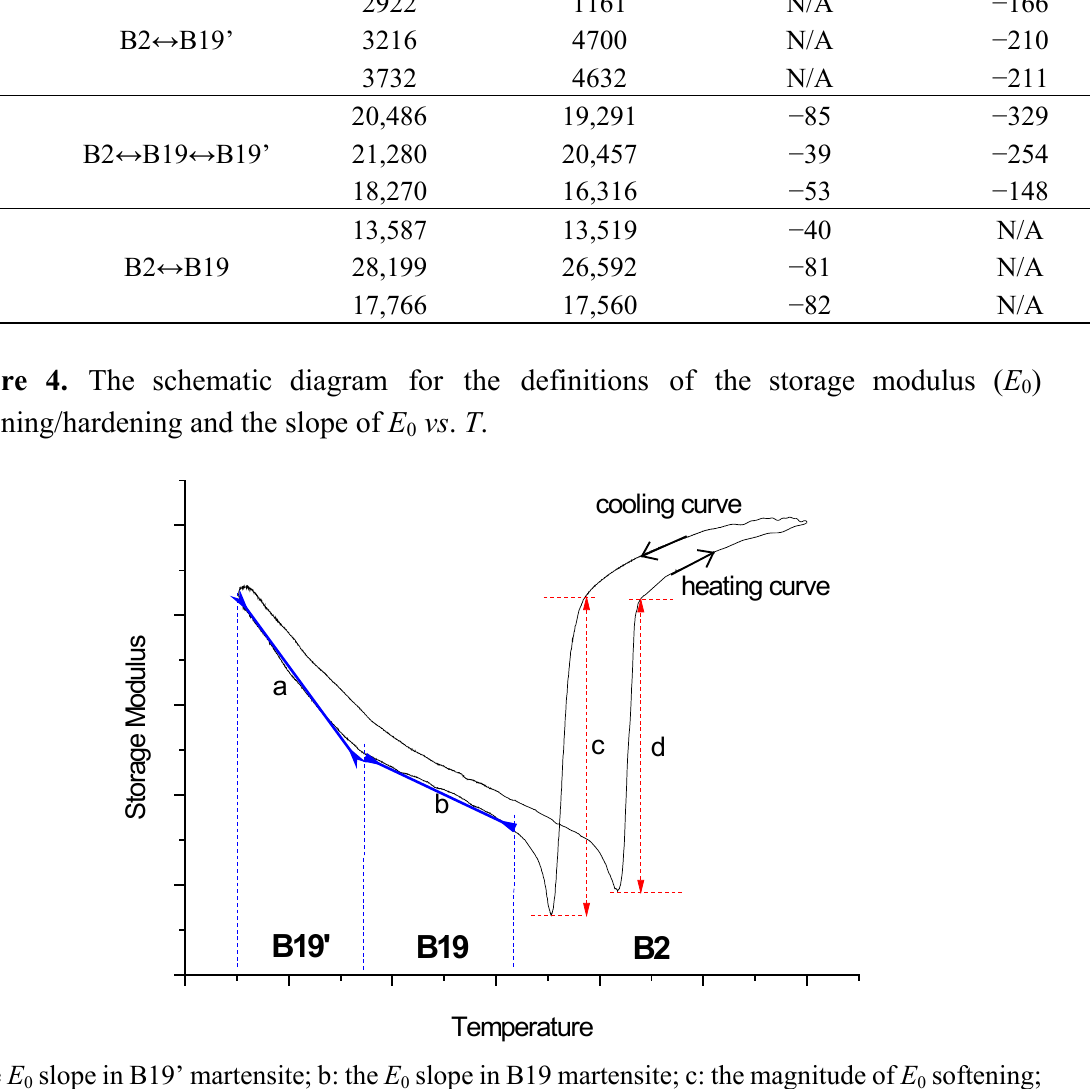
) softening/hardening and the slope of E 0